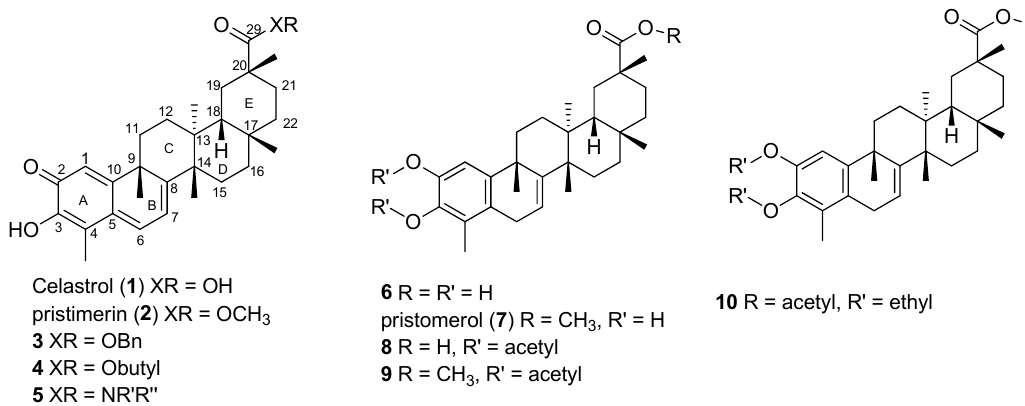
Figure 1. Structures of celastrol and its